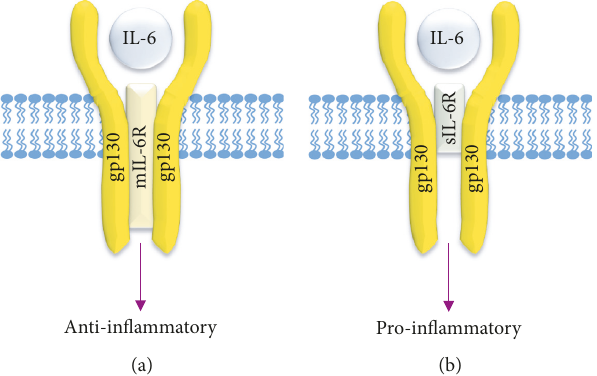
Figure 3: IL-6 classical and trans-signalling. (a) In classical signalling, IL-6 binds to a membrane-bound IL-6 receptor molecule in addition to two flanking gp130 molecules. Signalling through this pathway mediates anti-inflammatory signalling and is prevalent in blood cells and hepatocytes. (b) Trans-signalling occurs on the majority of other cell types, including cells of the vascular walls. Here, a soluble IL-6 receptor molecule is utilised in combination with two gp130 molecules. This truncated, soluble IL-6 receptor is responsible for many of the proinflammatory actions of IL-6 in